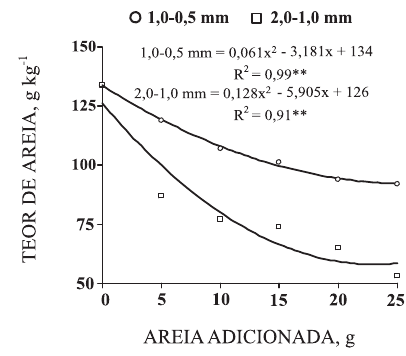
Figura 3. Efeito da adição de areia nos teores de areia do Nitossolo Vermelho eutroférrico (NVef). **: significativo (p <